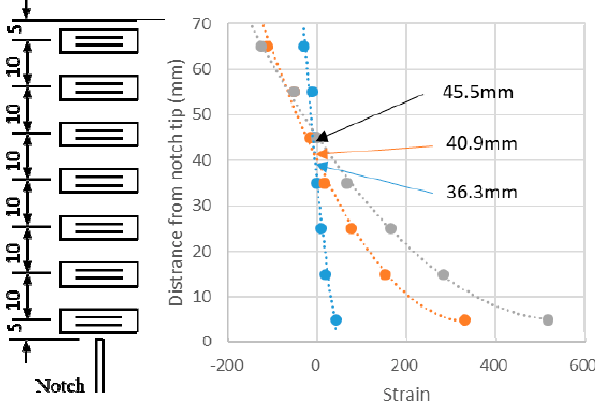
Figure 6. Estimation of a neutral axis. Table 3. Estimated neutral axis with different load level.